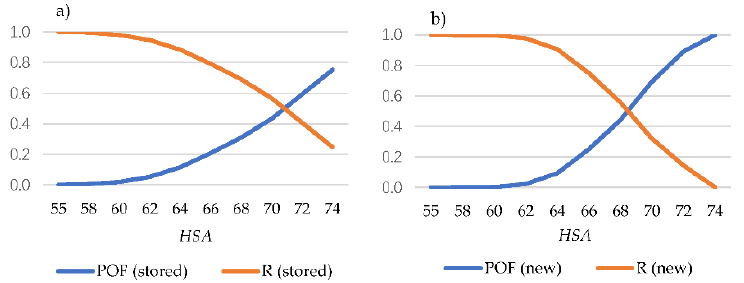
Figure 14. Reliability and probability of failure as a function of the measured hardness for the ( a ) stored and ( b ) recently manufactured O-rings.